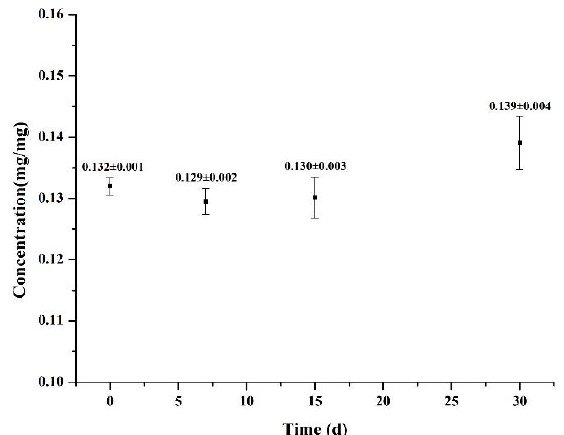
Figure 3. The stability of α -TOC in freeze-dried nanoparticles during 30 days storage. The unit mg/mg means the amount of α -TOC per milligram of freeze-dried α -TOC-NaOl/RebA complexes. Error bars are standard deviations ( n = 3).